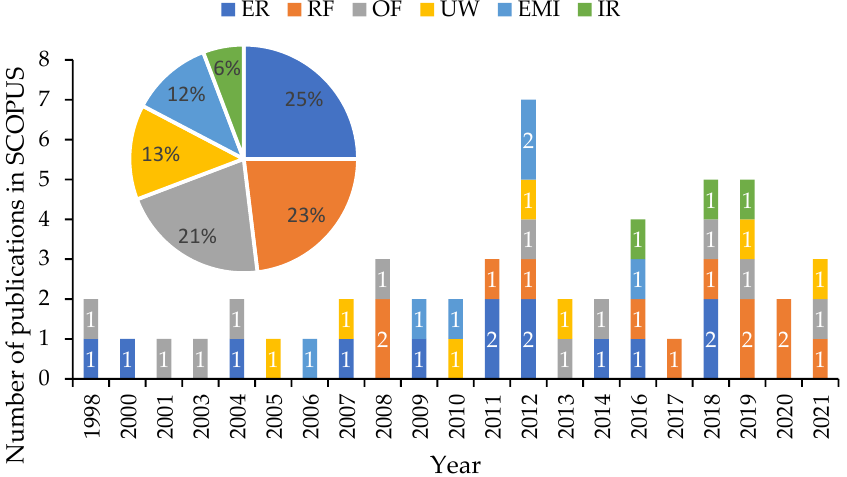
Figure 12. Distribution of the reviewed articles associated with the application of physical methods for corrosion monitoring from 1986 to 2021.